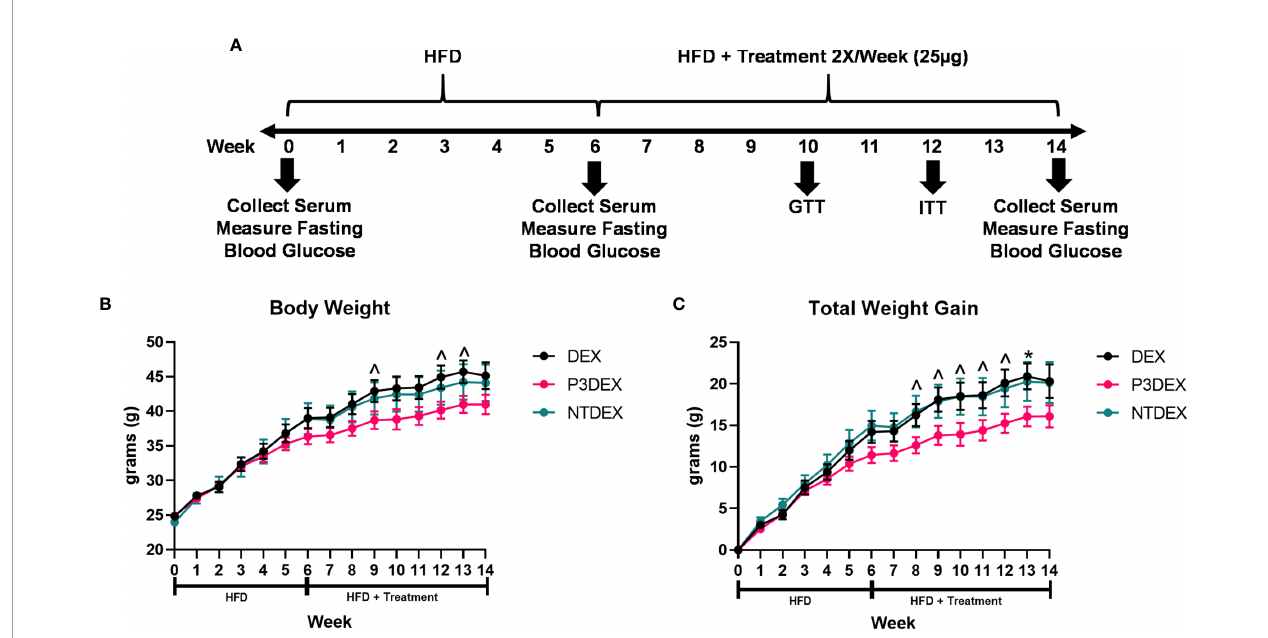
FIGURE 1 | LNFPIII conjugates reduce total body and organ weights. (A) Experimental design. Male C57BL/6 mice were placed on HFD for 6 weeks prior to intervention twice per week with 25 m g DEX, P3DEX, or NTDEX. (B, C) P3DEX reduces total body weight and weight gain. Two-way ANOVA with Dunnett ’ s Multiple Comparisons Test. (D – F) P3DEX reduces scWAT and WAT, but not BAT. (G – J) P3DEX and NTDEX have no effect on liver, heart, spleen, and kidney weights. One- way ANOVA with Dunnett ’ s Multiple Comparisons Test. *indicates a signi fi cant difference between DEX and P3DEX (p ≤ 0.05). ^indicates a trend between DEX and P3DEX (p ≤